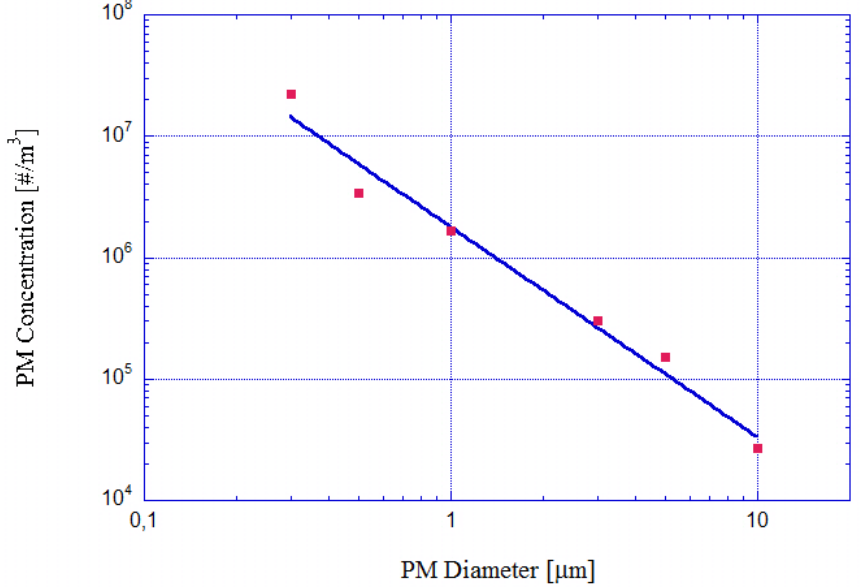
Figure 7. PM average numeric size distribution (log scale) monitored in Strinella Street, L’Aquila, in the period January 2016–April 2016. The blue line indicates the power fit. Data collected by Optical Particle Counter (OPC) TSI .